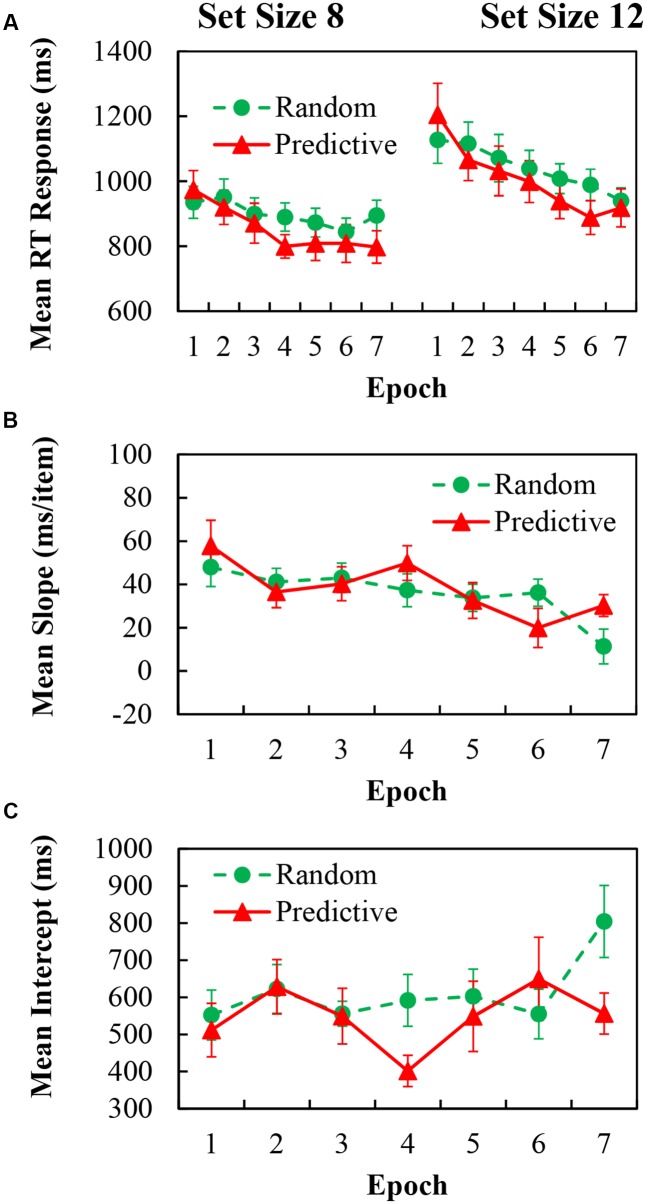
(A) Mean correct RTs in each epoch for predictive (red) and random (green) configurations in set size 8 (Left) and set size 12 (Right) of Experiment 1. (B) Search slopes (ms/item) for predictive (red) and random (green) configurations over epoch of Experiment 1. (C) Intercepts (ms) for predictive (red) and random (green) configurations over epoch of Experiment 1.